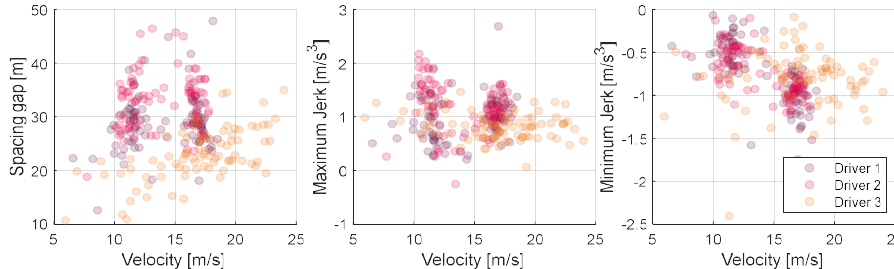
Figure 4. Driving feature distributions according to ego-vehicle velocity; distributions of spacing gap, maximum jerk and minimum jerk